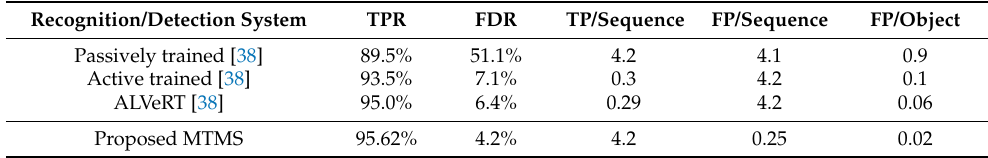
Table 1. Experimental results on LISA LDB1 dataset.